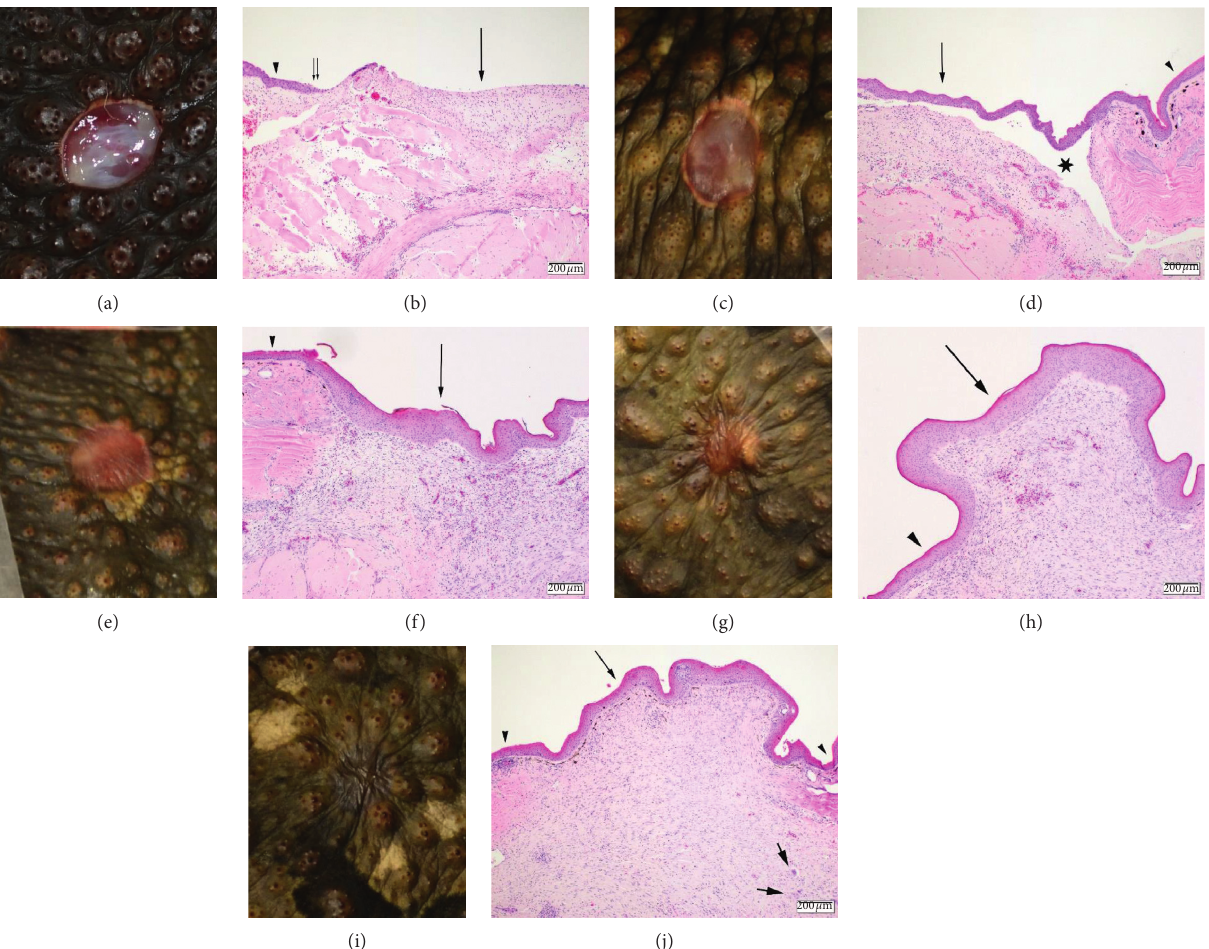
Figure 2: Gross and corresponding histologic images showing the healing progression of surgically induced 6 mm diameter fill-thickness dermal wounds in marine toads ( Rhinella marina ) in the control group at day 4 (a, b), day 7 (c, d), day 13 (e, f), day 19 (g, h), and day 28 (i, j). Histologic sections were stained with hematoxylin and eosin. The scale bar represents 200 micrometers. 2b: there is a thin layer of new epithelial growth (thin double arrows) that extends from the edge of the ulcer (arrowhead). There is a mild, predominately lymphocytic infiltrate, scattered within the tissue below the area of ulceration (arrow). 2d: the area of ulceration is completely covered by new epithelial growth (arrow) which is disorganized and easily separated from the underlying dermis (star) compared to the adjacent skin (arrowhead). A mild lymphocytic infiltrate and small amount of granulation tissue are present within the underlying dermis. 2f: the epithelium covering the previous area of ulceration (arrow) is disorganized and thickened (up to four times the adjacent epidermis (arrowhead)). Granulation tissue and early fibrosis are evident within the underlying dermis which also contains a moderate, diffuse, lymphocytic infiltrate. 2h: similar to 13 days, the new epithelium (arrow) is thicker and disorganized compared to the adjacent dermis (arrowhead). There is moderate fibrosis within the underlying dermis with prominent contracture of the wound resulting in projection of the affected region. 2j: the new epithelium is returning to normal thickness and organization (arrow) relative to the adjacent skin (arrowhead) and the dermal contraction is markedly reduced compared to day 19. Lymphocytes still diffusely infiltrate the dermis and form aggregates along the margin along with rare multinucleated giant cells (thick short arrows). Melanocytes are present within the superficial dermis of the previously ulcerated area; however, no adnexal structures are